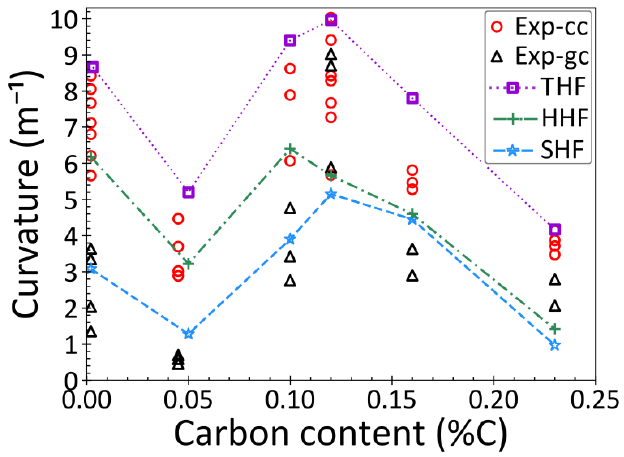
Figure 9. Comparison of predicted (lines) and measured (symbols: Exp-cc and Exp-gc) curvature of the bottom surface of the solidified droplets for six steel grades investigated with different heat flux profiles.